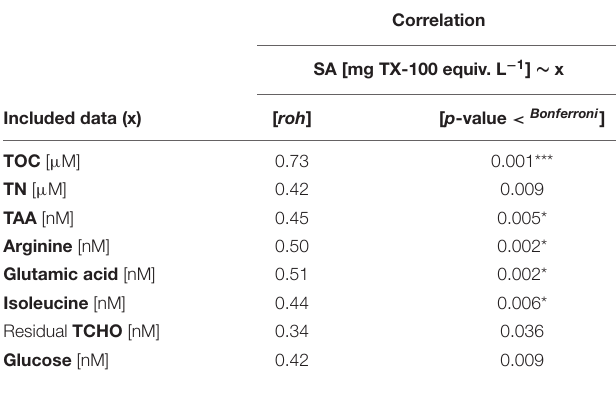
TABLE 3 | Correlation between surfactant and organic matter